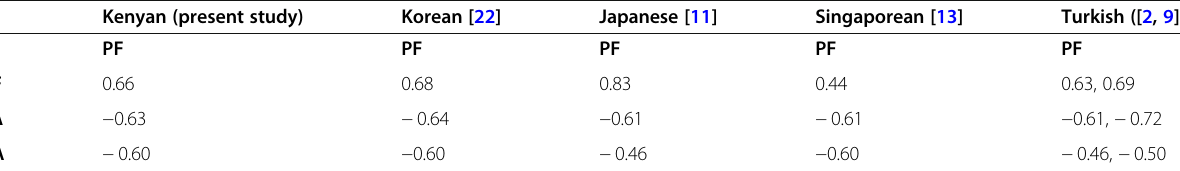
Table 4 Comparisons of Correlation Coefficients Between the Physical Functioning scale and Each of the Role Functioning, Fatigue, and Pain scales Across Populations